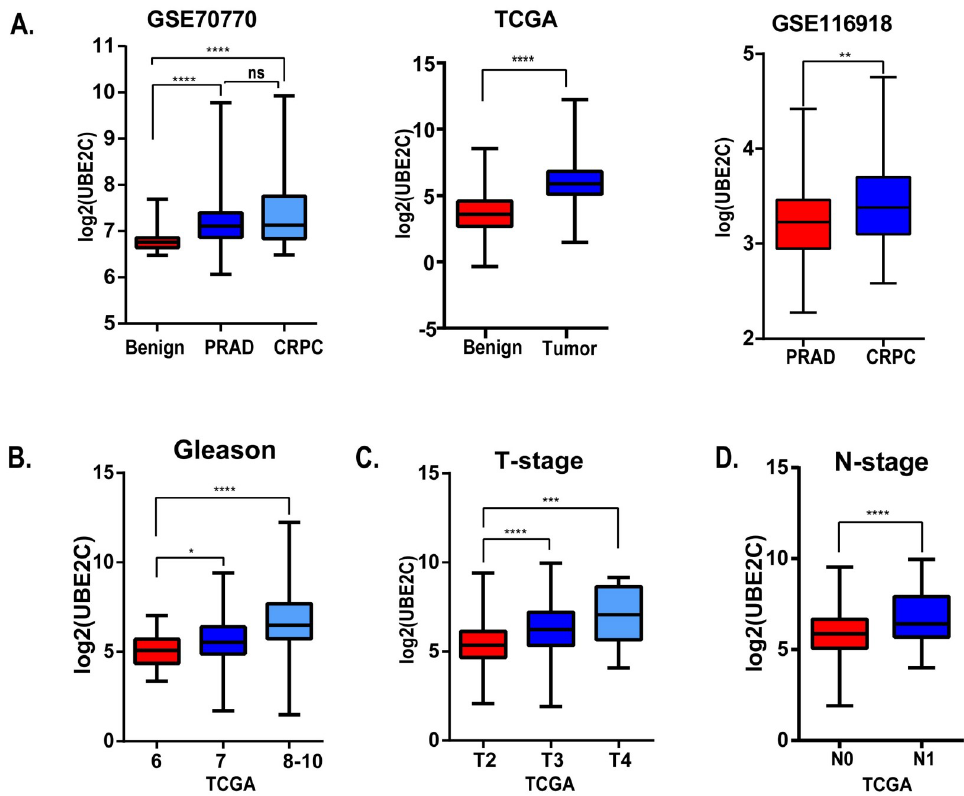
Fig 6. The correlations between UBE2C and clinical parameters. (A) The expression level of UBE2C of benign prostate tissue, prostate cancer and castration-resistant prostate cancer in GSE70770 (left), TCGA (middle) and GSE116918 (right). (B) The relationship between Gleason score and UBE2C in TCGA. (C) The relationship between T-stage and UBE2C in TCGA. (D) The relationship between N-stage and UBE2C in TCGA. � : p < 0.05; �� : p < 0.01; ��� : p < 0.001; ���� : p <